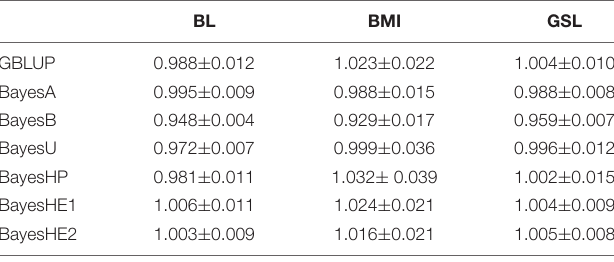
TABLE 5 | Prediction biases of mice data using six-fold cross-validation with five replications.